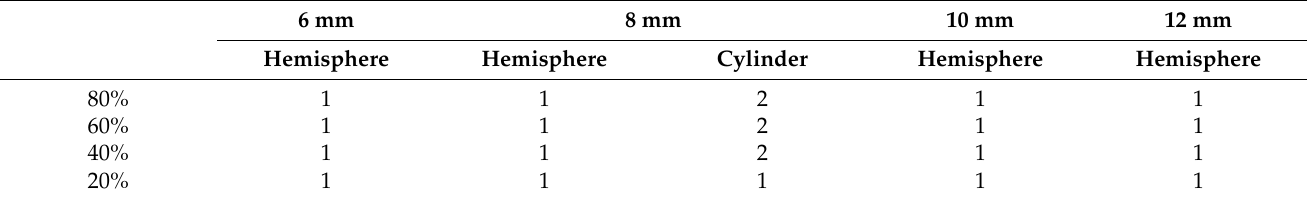
Table 5. Relevant parameters of the test